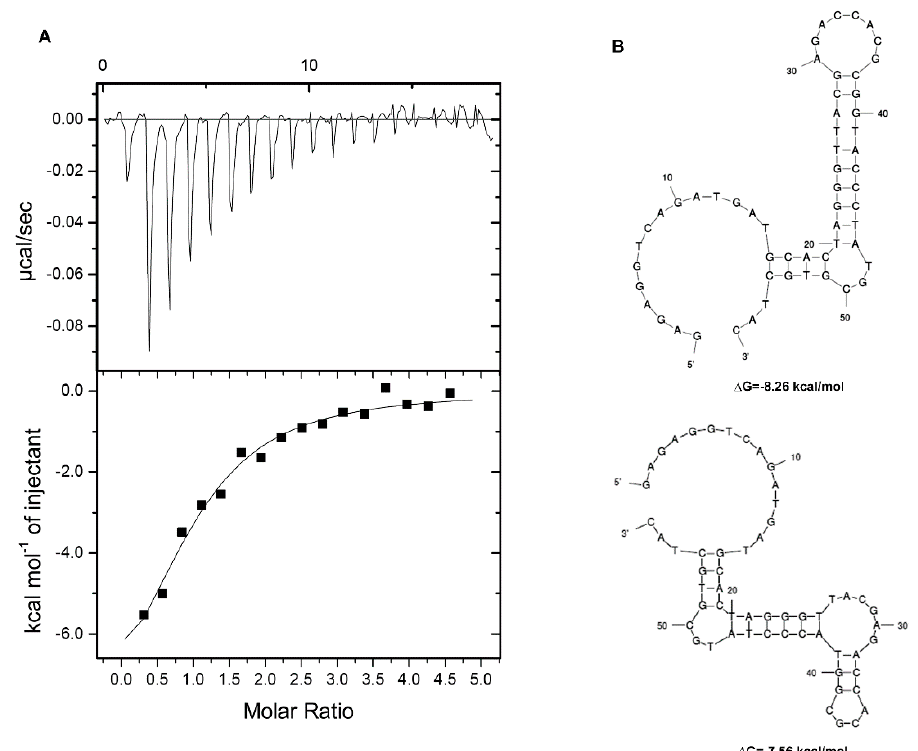
Figure 2. Binding affinity of the aptamer fl − 2CS1 with AFB1 determined by isothermal titration calorimetry (ITC). ( A ) ITC measurement of the selected aptamer fl − 2CS1 with AFB1. ( B ) Structural prediction of the fl − 2CS1 and the changes of Gibbs free energy.